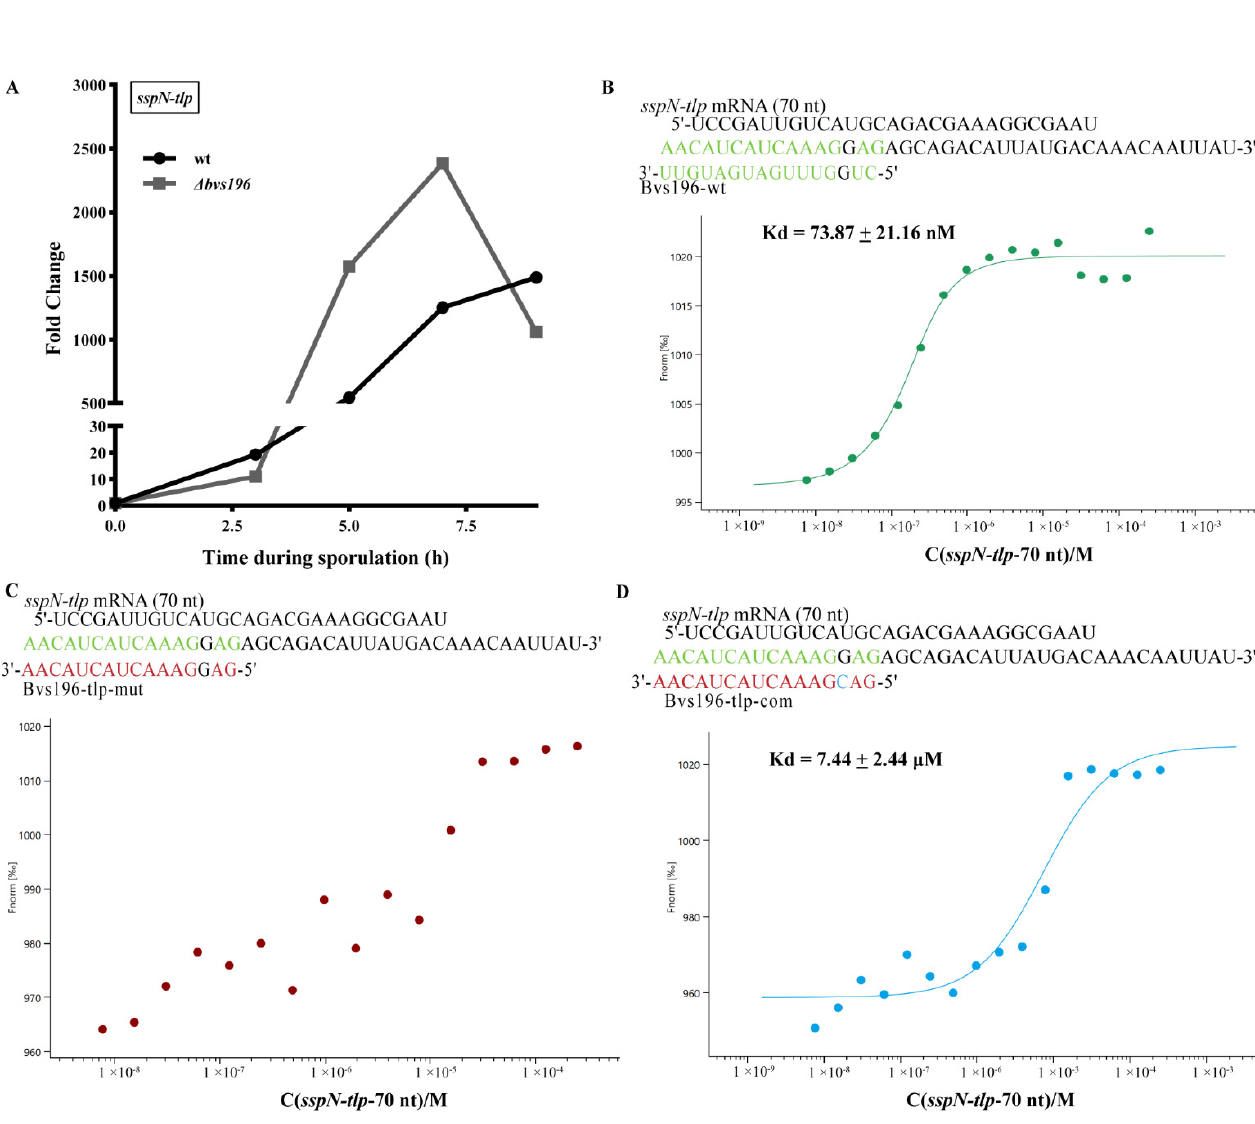
Figure 6. Transcriptional level of sspN-tlp and the binding affinity of sRNA Bvs196 with sspN-tlp by MST analysis in vitro. ( A ) Temporal transcriptional expression of sspN-tlp during sporulation in wt and Δ bvs196 . qPCR was used to calculate the relative expression levels of sspN-tlp from wild-type (wt)- and Δ bvs196 strain-induced sporulation by RM medium at 37 °C. Time shown is hours after resuspension in RM medium, and the relative expression levels are represented as the fold change to wt at t = 0. Data shown is averages from triplicates. ( B – D ) Paired bases are shown in green. Point mutations are shown in red and blue. The Kd value means the binding affinity between two molecules; wt indicates wild type; mut indicates mismatch mutation; com indicates compensatory mutation. ( B ) sspN-tlp mRNA (70 nt)/Bvs196-wt, the green curve; ( C ) sspN-tlp mRNA (70 nt)/Bvs196